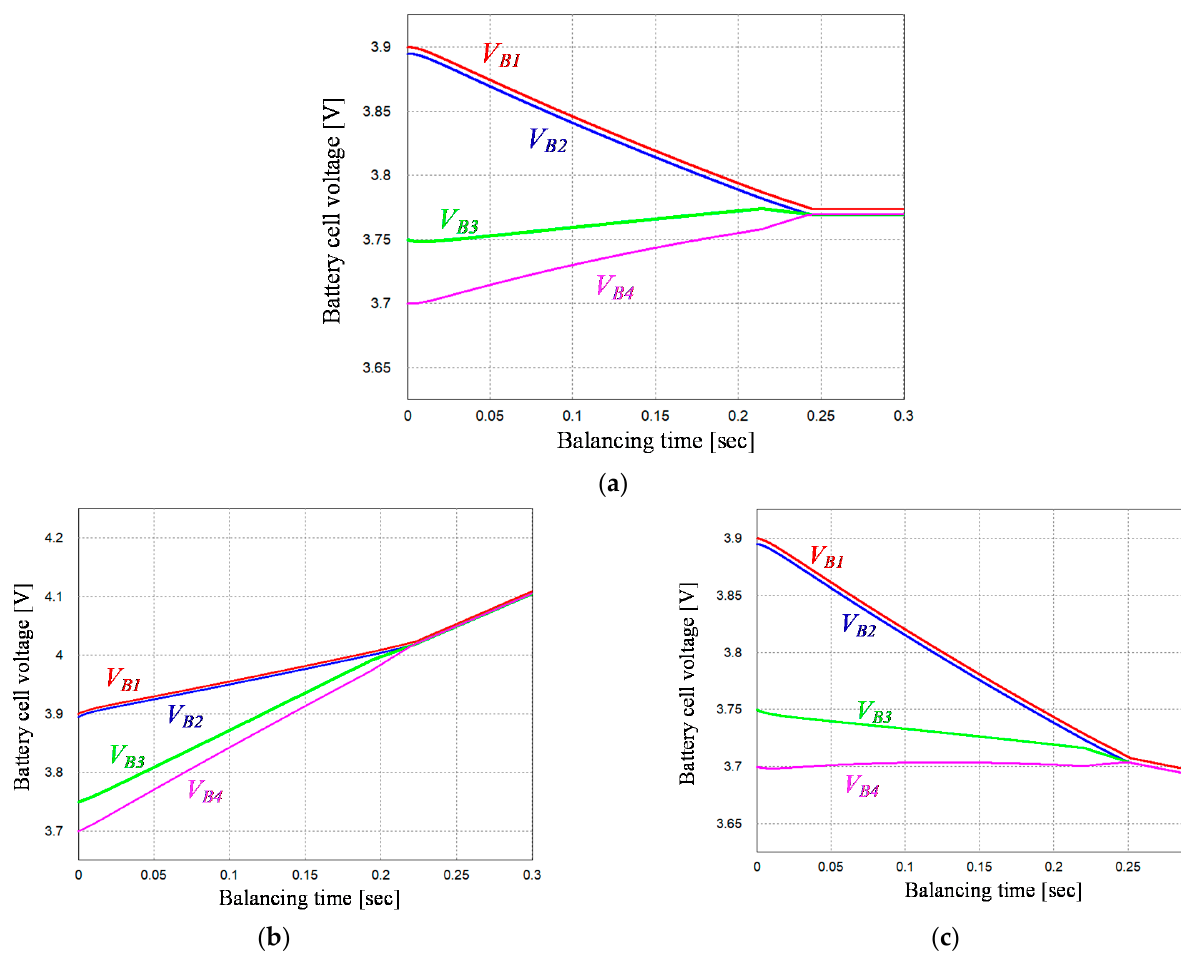
Figure 12. Simulation results of the proposed circuit in various conditions: ( a ) standalone condition, ( b ) charging condition, and ( c ) discharging condition.